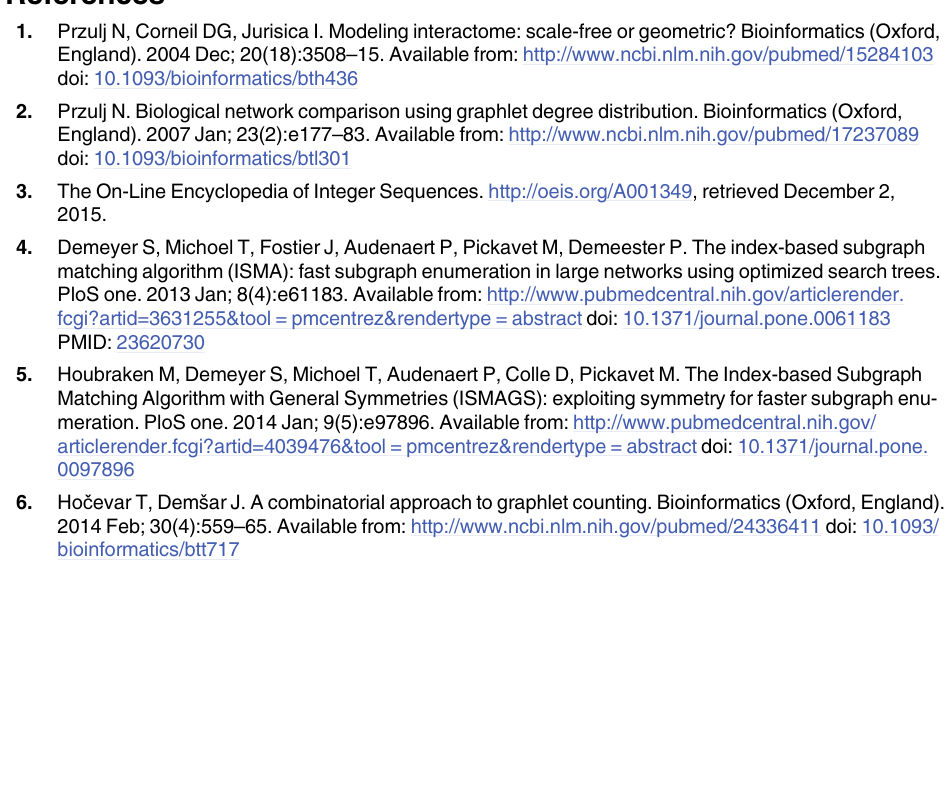
S1 Fig. Graphlets of order 6. All graphlets of order 6 are shown in the newly introduced order. In the lower left corner of each page, the graphlet ’ s orbits are listed in their